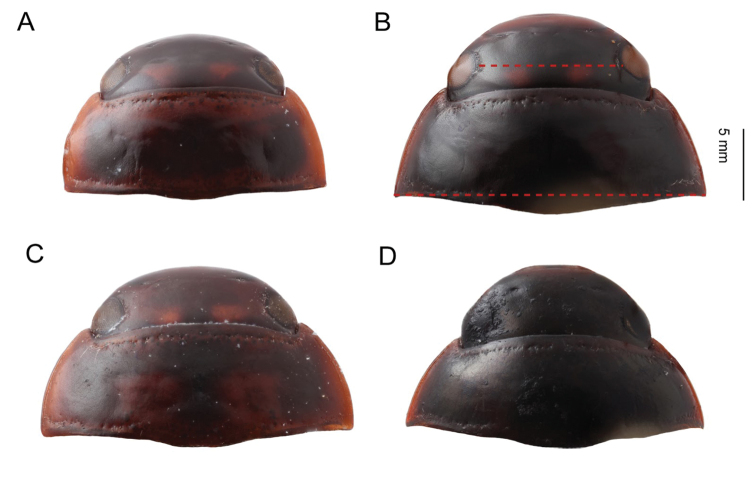
Agabus spp., head and pronotum in dorsal view AA.
dytiscoidesBA.
ruwenzoricusCA.
sjostedtiDA.
pallidus. Red dashed lines indicate measurements used for interocular distance and pronotal width.